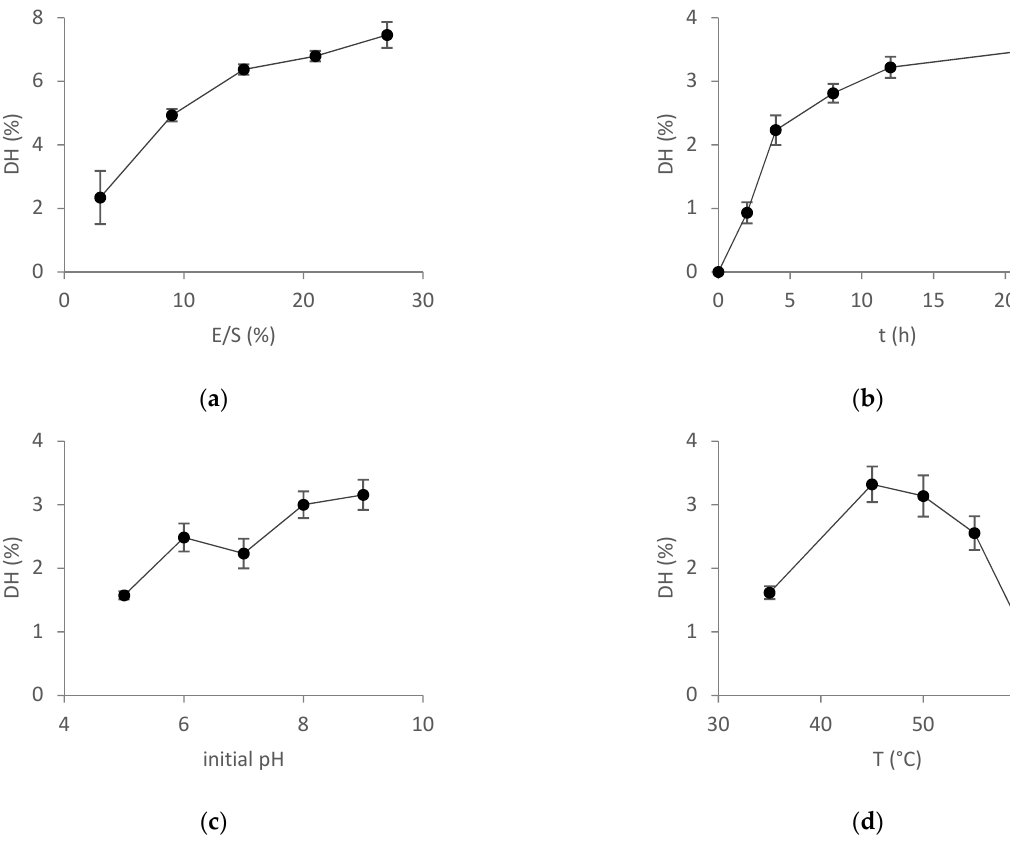
Figure 3. Main effect plots of OFAT experiments on ( a ) DH vs. E/S ratio, ( b ) DH vs. incubation time, ( c ) DH vs. initial pH, and ( d ) DH vs. hydrolysis temperature. Data are expressed as mean ± standard deviation of triplicate determinations.